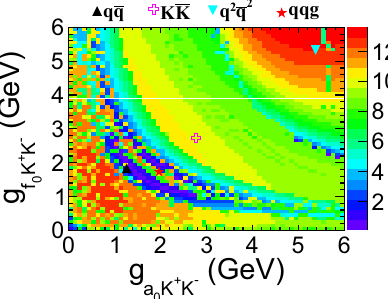
Figure 5. The statistical significance of the signal scanned in the two-dimensional space of g a g f + K − . The regions with higher statistical significance indicate larger probability for the emergence 0 K of the two coupling constants. The markers indicate predictions from various illustrative theoretical